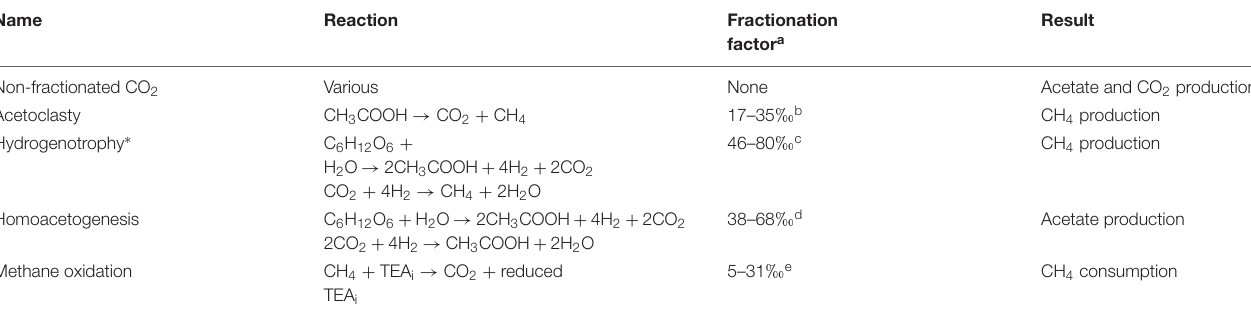
TABLE 1 | Five reactions explicitly considered in rate